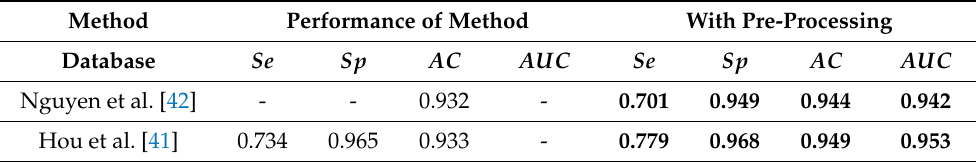
Table 4. Effectiveness of Pre-processing Module on Existing Method: STARE Database.